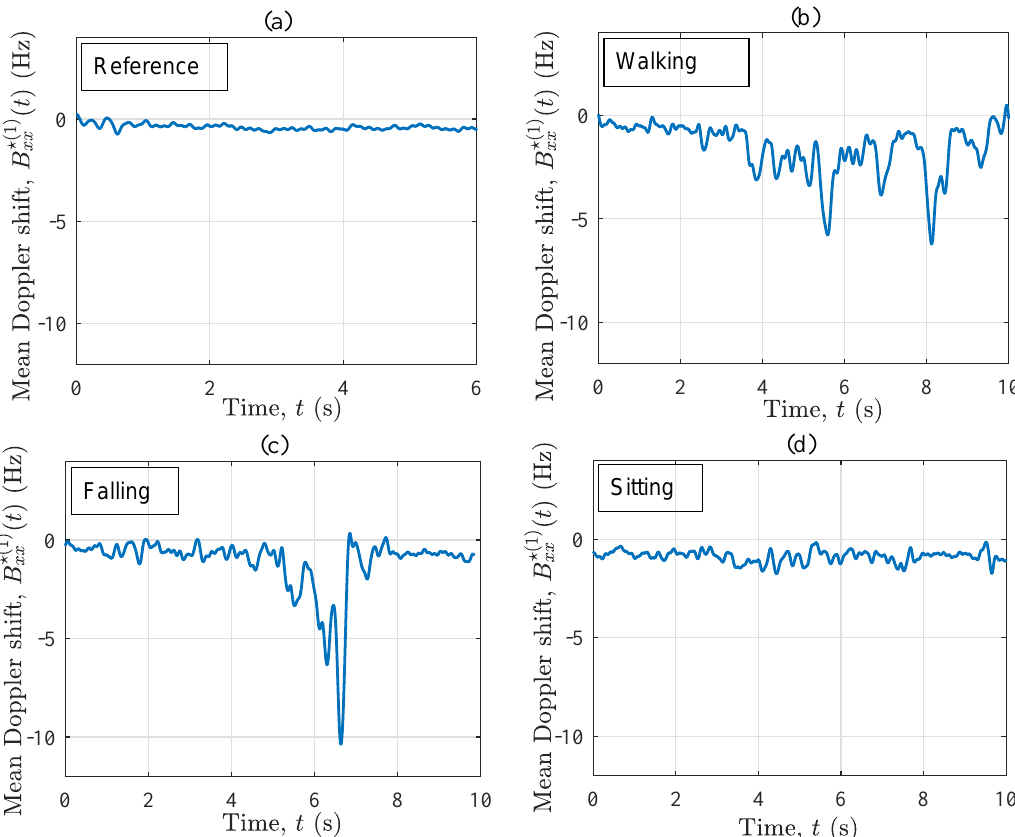
(cid:63) ( 1 ) ( t ) for the four scenarios in S2: ( a ) reference, xx